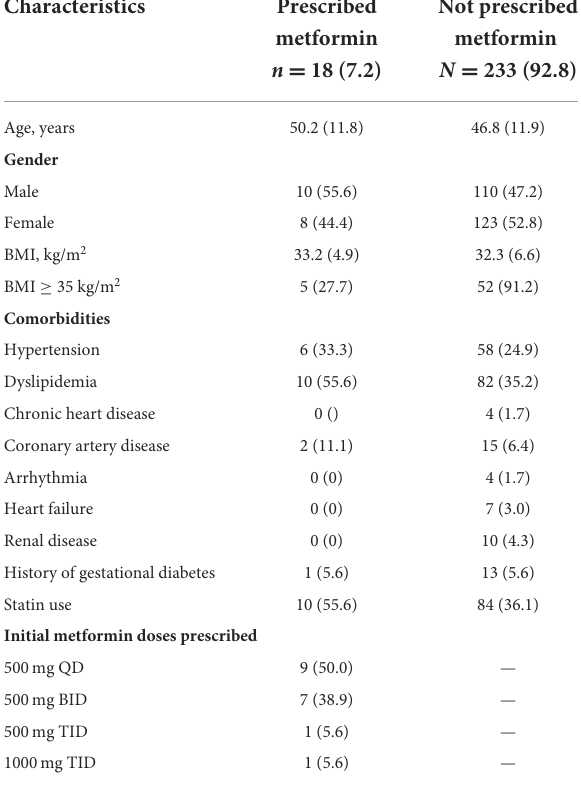
TABLE 3 Patients’ characteristics based on the prescribing of metformin. Characteristics